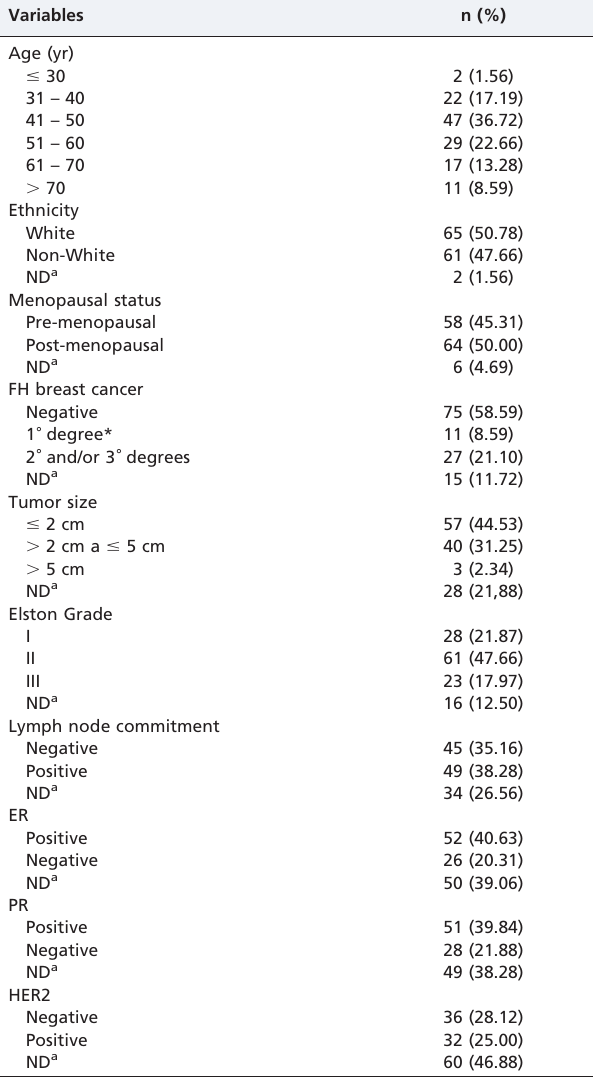
Table 1 - Sociodemographic of and tumor characteristics in patients (n = 128).